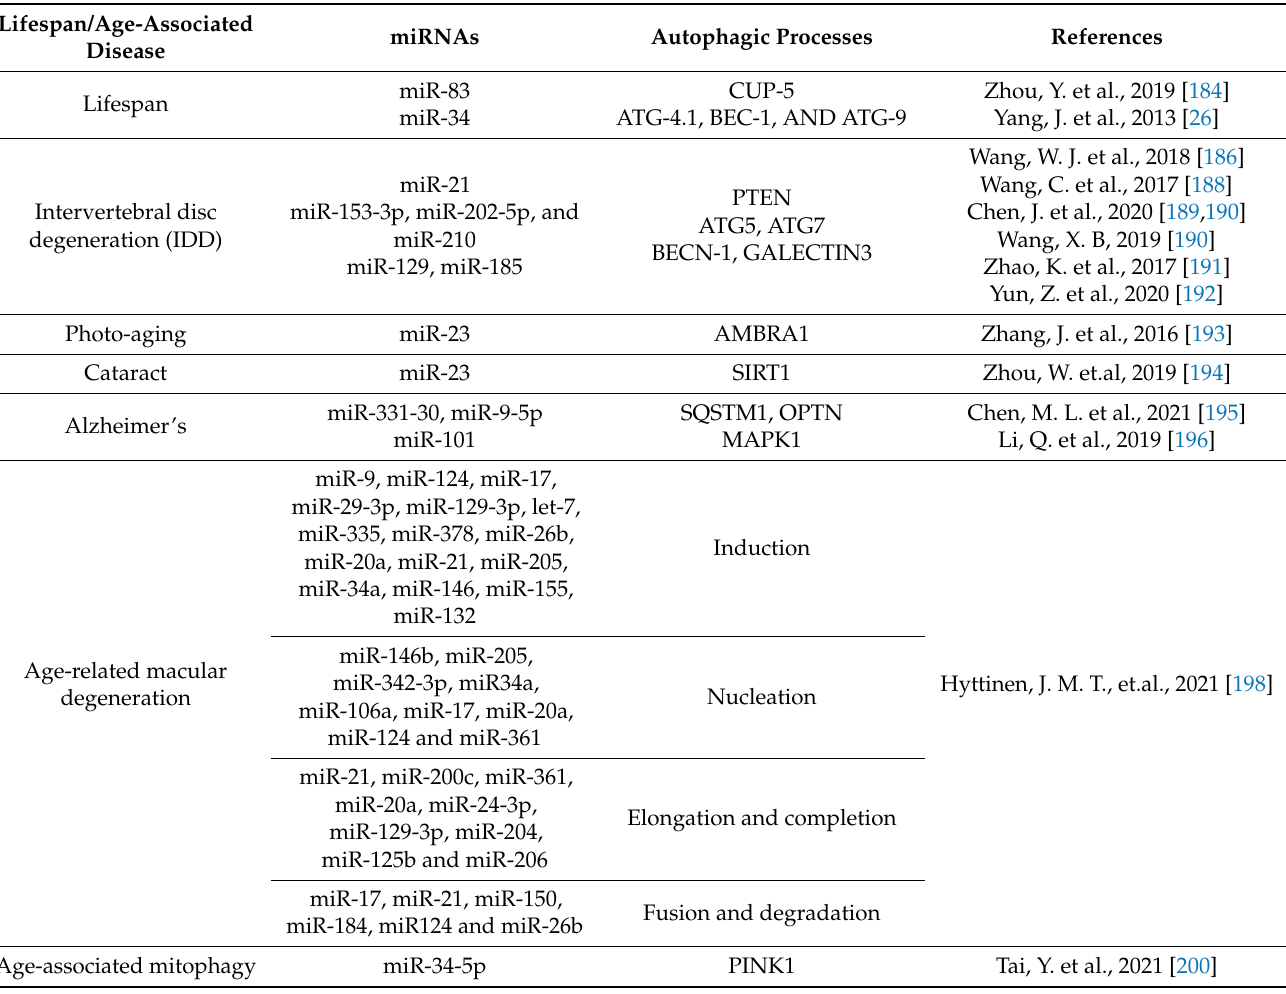
Table 2. miRNAs involved in regulation of autophagic processes in various age-associated